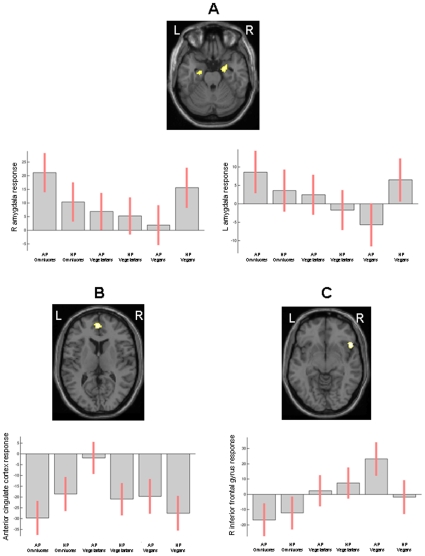
Interactions between stimuli (animal/human) and groups (omnivore/vegetarian/vegan).An interaction was found in the right amygdala (A), indicating greater increase to animal negative valence picture view in omnivores and to human negative valence picture view in vegans. An interaction between “human pictures” and “vegan group” was also found in the left amygdala (A). An interaction was found in ACC (B) between the “omnivore group” and “human pictures”, as well as between “vegetarian group” and “animal pictures”; and in the right IFG between “animal pictures” and “vegan group” (C). Foci of activations are shown on a high-resolution T1-weighted image in the standard MNI space. Plots indicate activation changes detected in the three groups during the two experimental conditions in each of these regions. Images are in neurological convention.